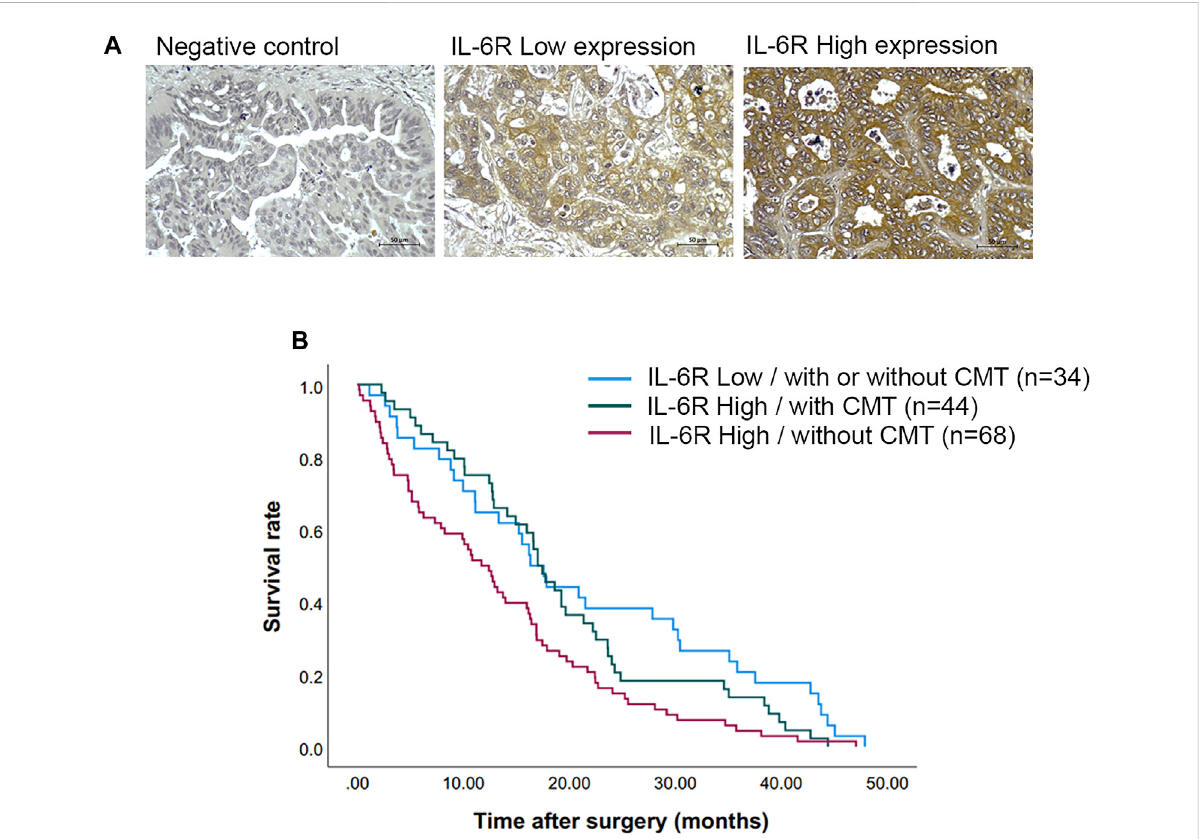
FIGURE 7 The expression of IL-6R in CCA tissues and correlation with overall survival rates of CCA patients. (A) Representative images demonstrated the expression ofIL-6RbyimmunohistochemicalstaininginCCAtissues. Originalmagni fi cationis×200. (B) TheKaplan-Meiersurvivalplotaccordingto IL-6RexpressionandthechemotherapyregimenofCCApatientsshowedthatthepatientswithIL-6Rhighexpressionwithoutchemotherapyhavea shorter survival time than those with low IL-6R expression and high IL-6R expression with chemotherapy (log-rank test, p = 0.005). CMT,